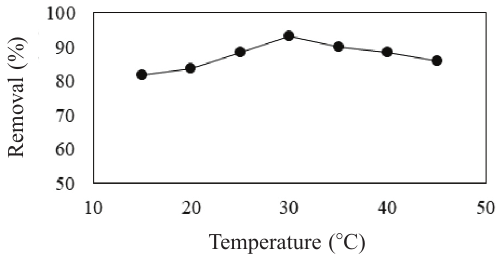
Fig. 5 – Effect of temperature on removal efficiency of TC onto Fe